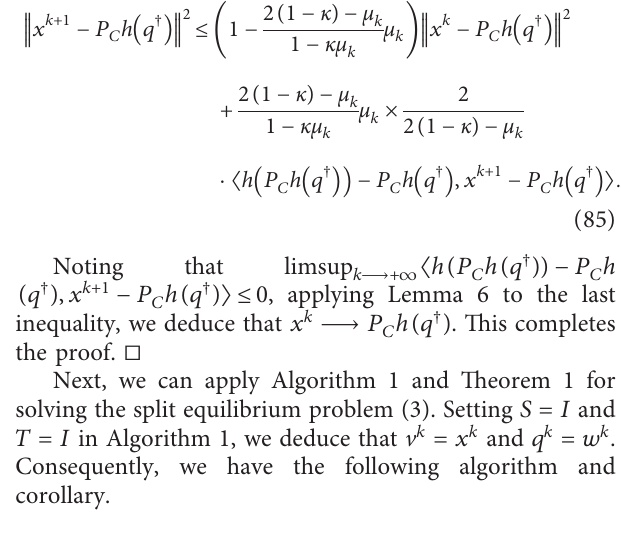
Algorithm 2. Fix an initial point x 0 ∈ C . Set k �